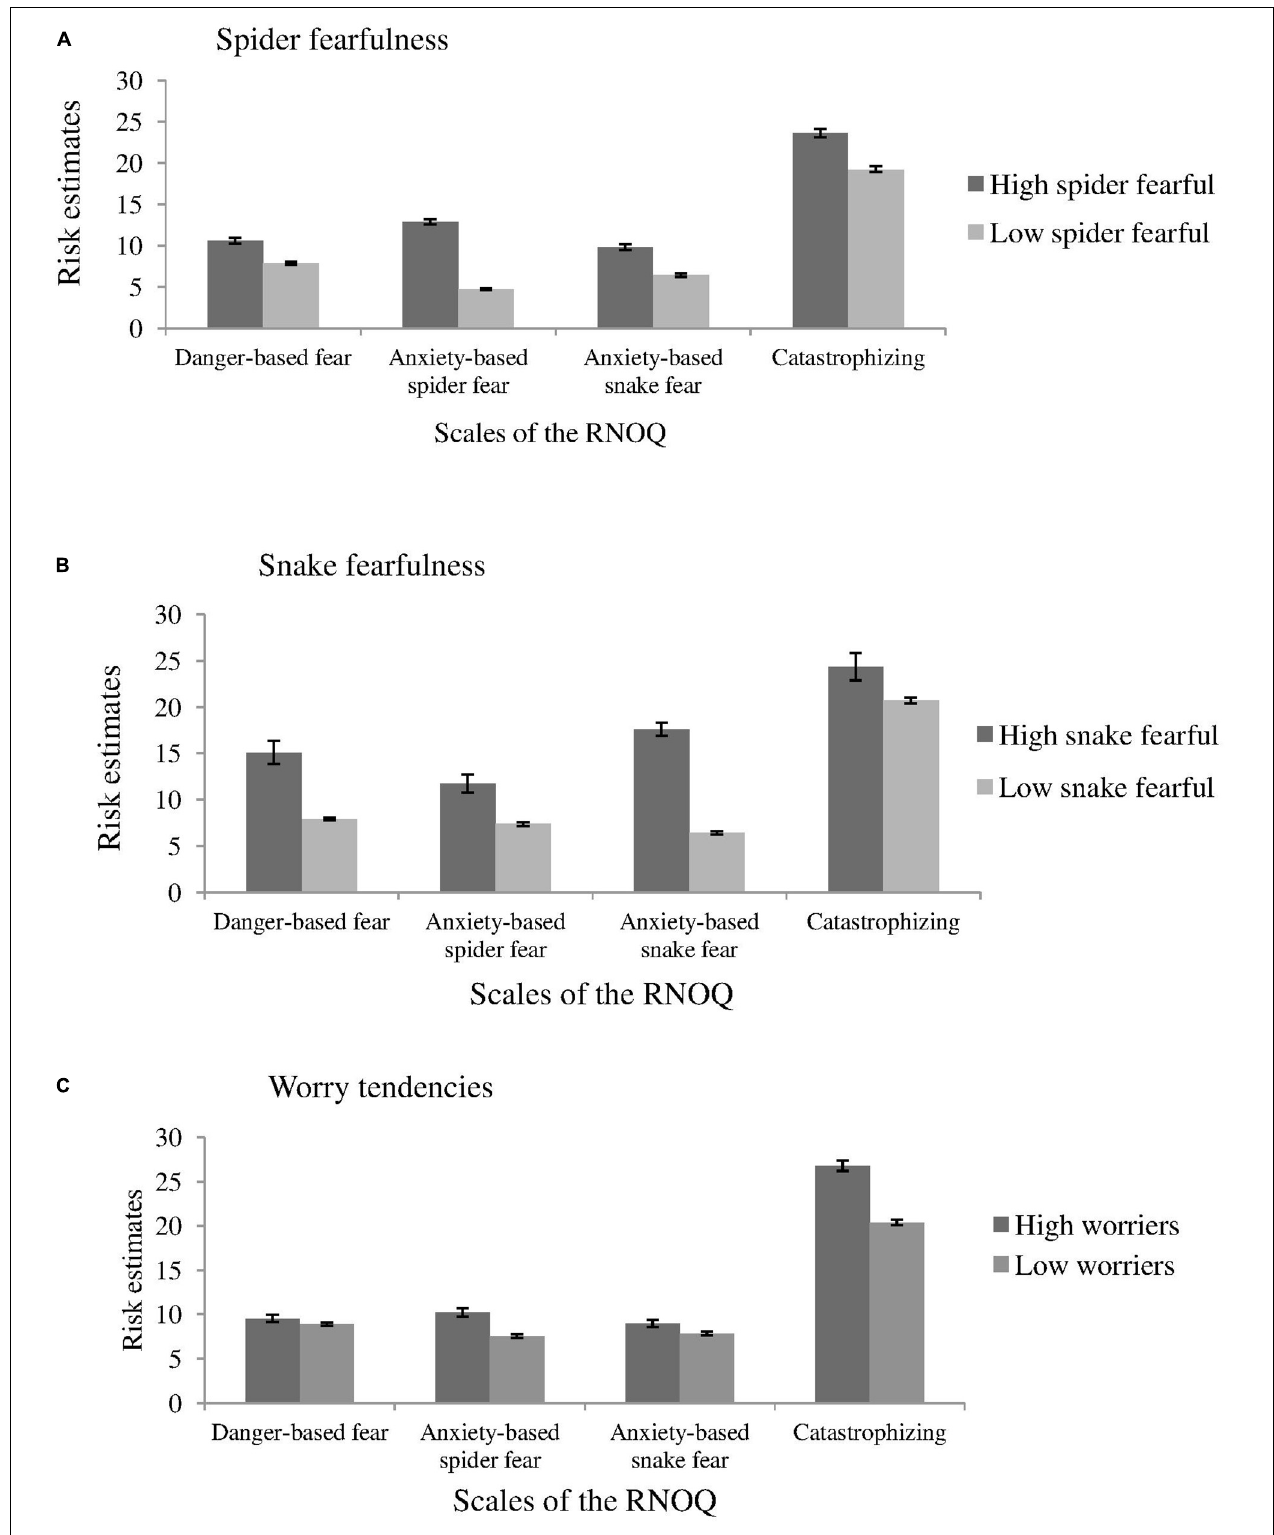
FIGURE 2 | Mean risk estimates of the extreme groups of each fear domain on the scales of the RNOQ. Error bars reflect the standard error of means. (A) Fear domain of spiders. (B) Fear domain of snakes. (C) Fear domain of everyday fear-triggers.